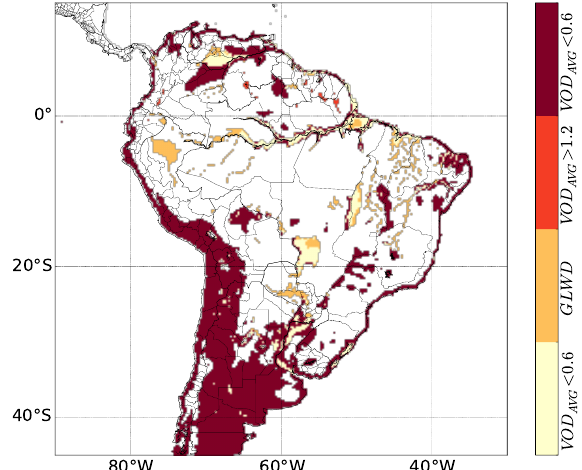
Figure 1. Grid cells that were excluded from our analysis: VOD avg: grid cells with an average VOD that is either above 1.2 or below 0.6 and thus outside the usable range for our study. GLWD: grid cells containing more than 50% open water, which makes the VOD signal unreliable. Both: grid cells containing more than 50% open water and where VOD is outside the usable